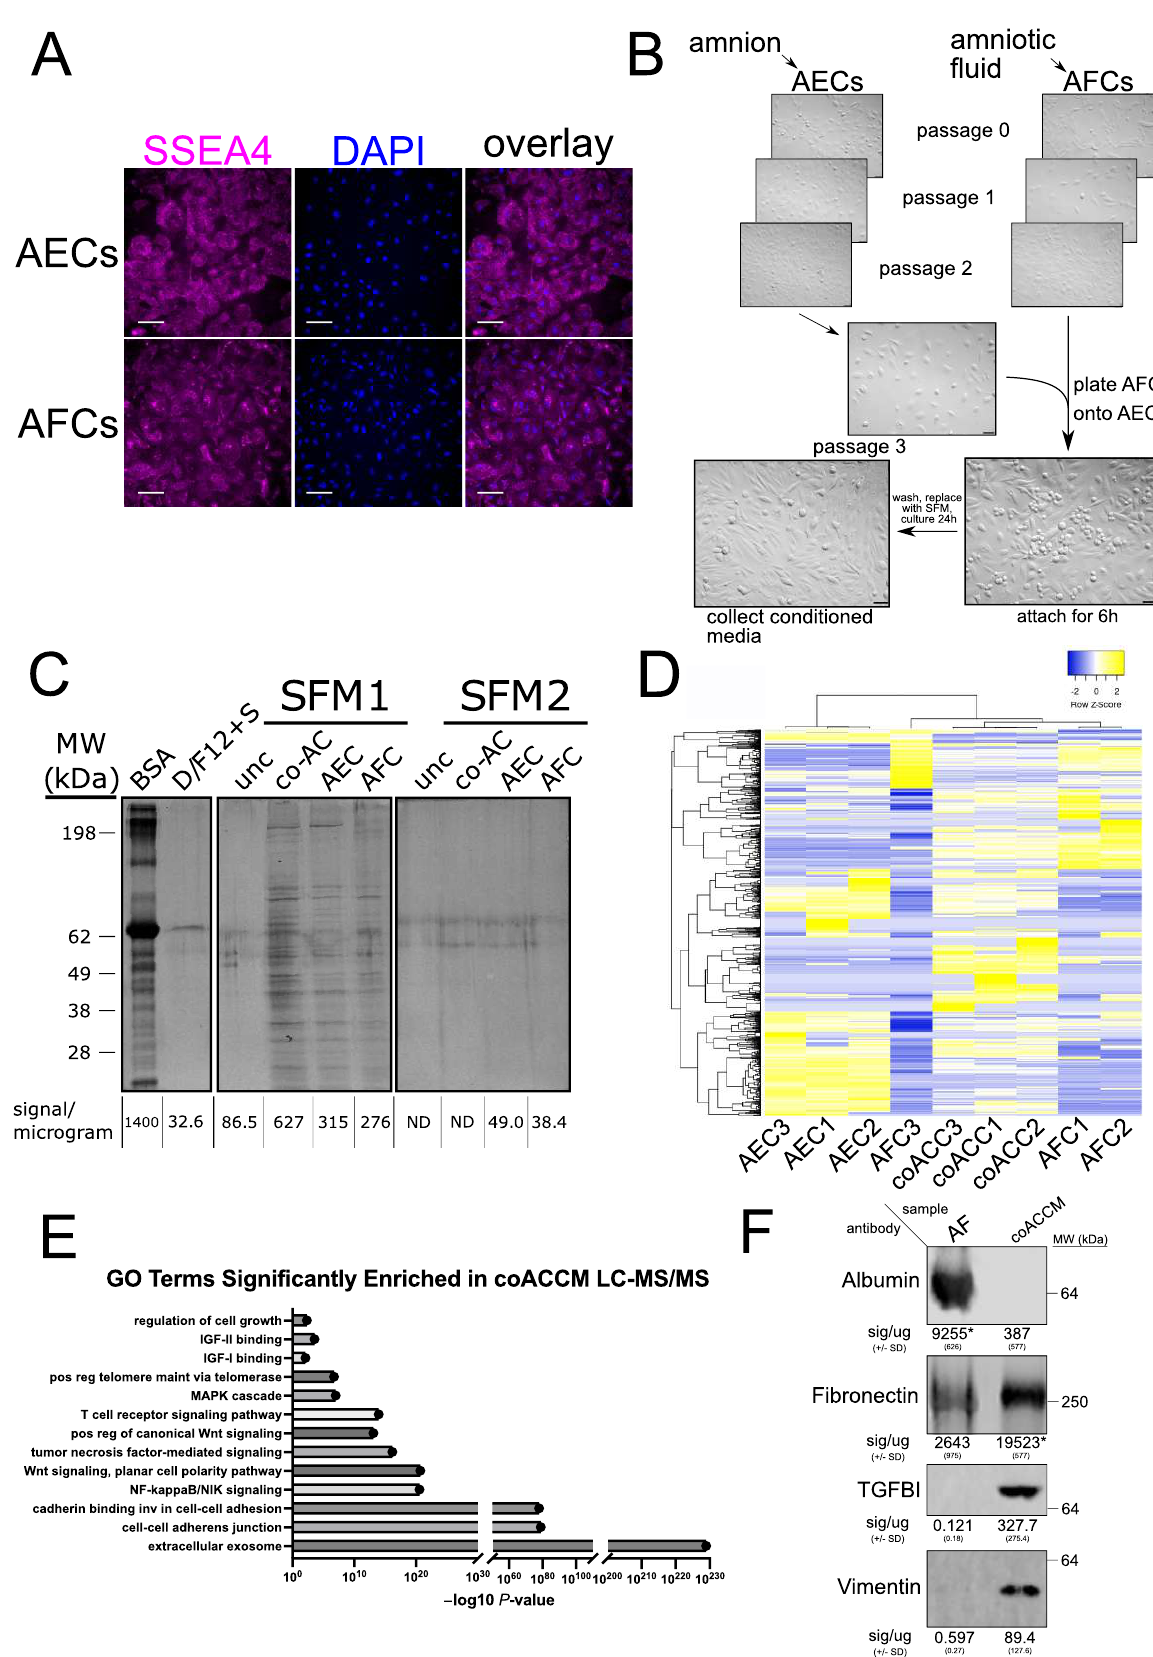
Figure 1. An optimized co-culture system to generate a robust secreted proteome. ( A ) Indirect im- munofluorescence using stage-specific antigen 4 (SSEA4) antibody (magenta, left ), DAPI (blue, middle